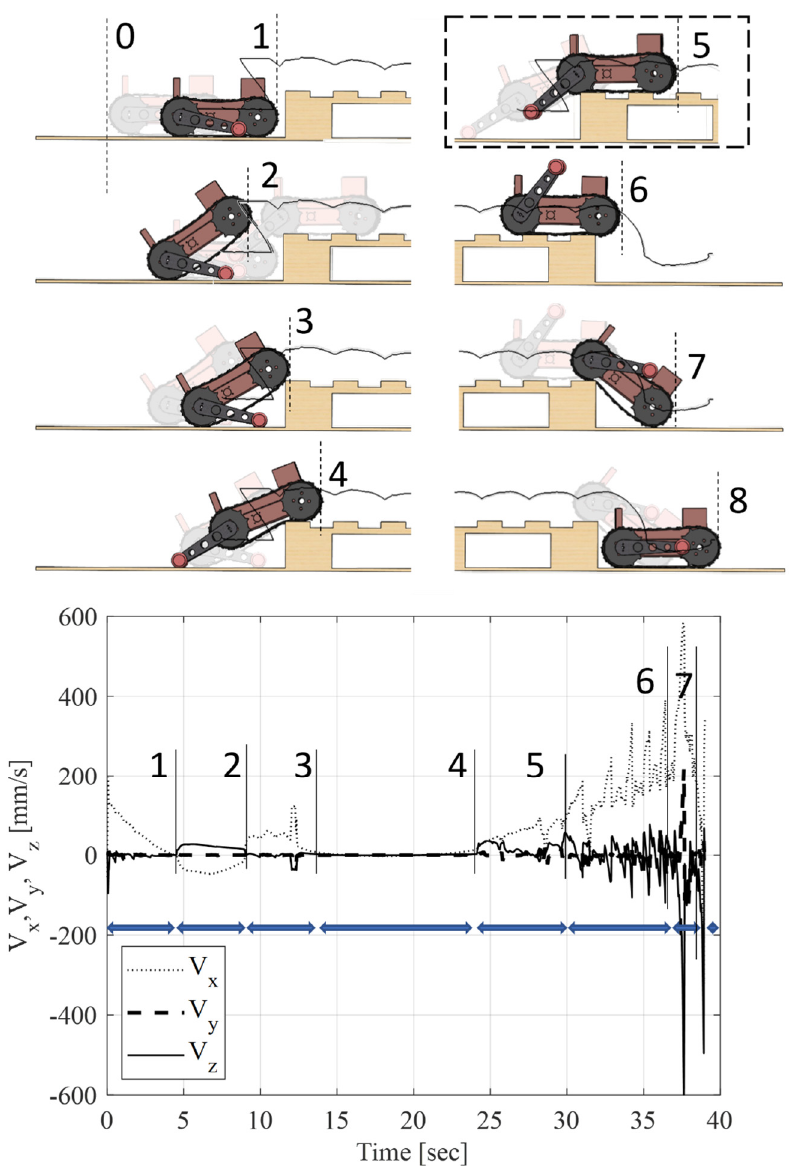
Figure 8. Experimental/numerical tests of the behavior of the robot in Figures 6 and 7 in negotiating with stepfield pallet. 1: approach to the obstacle, 2: activation of the legs and the hybrid robot inclines, 3: robot moves forward next to the stepfield pallet, 4: legs rotating clockwise to touch the ground and lift the robot, 5: tracks are activated to move the robot forward, 6: motion on the pallet, 7: descending phase, 8: the robot is completely out of the obstacle.